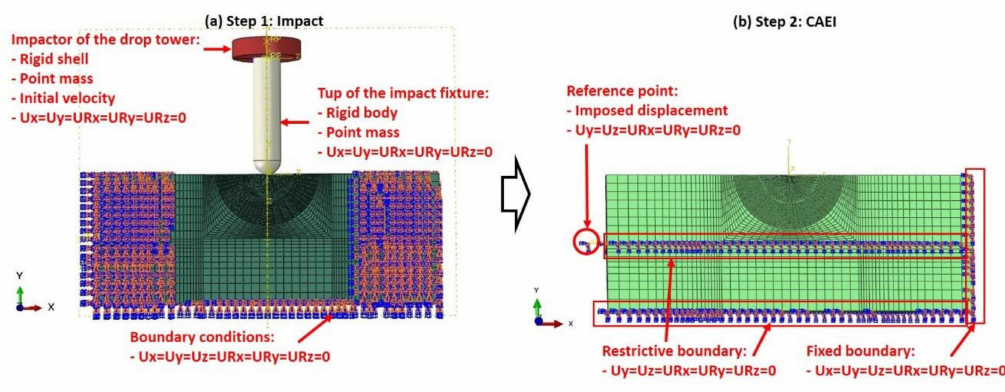
Figure 6. Finite element model